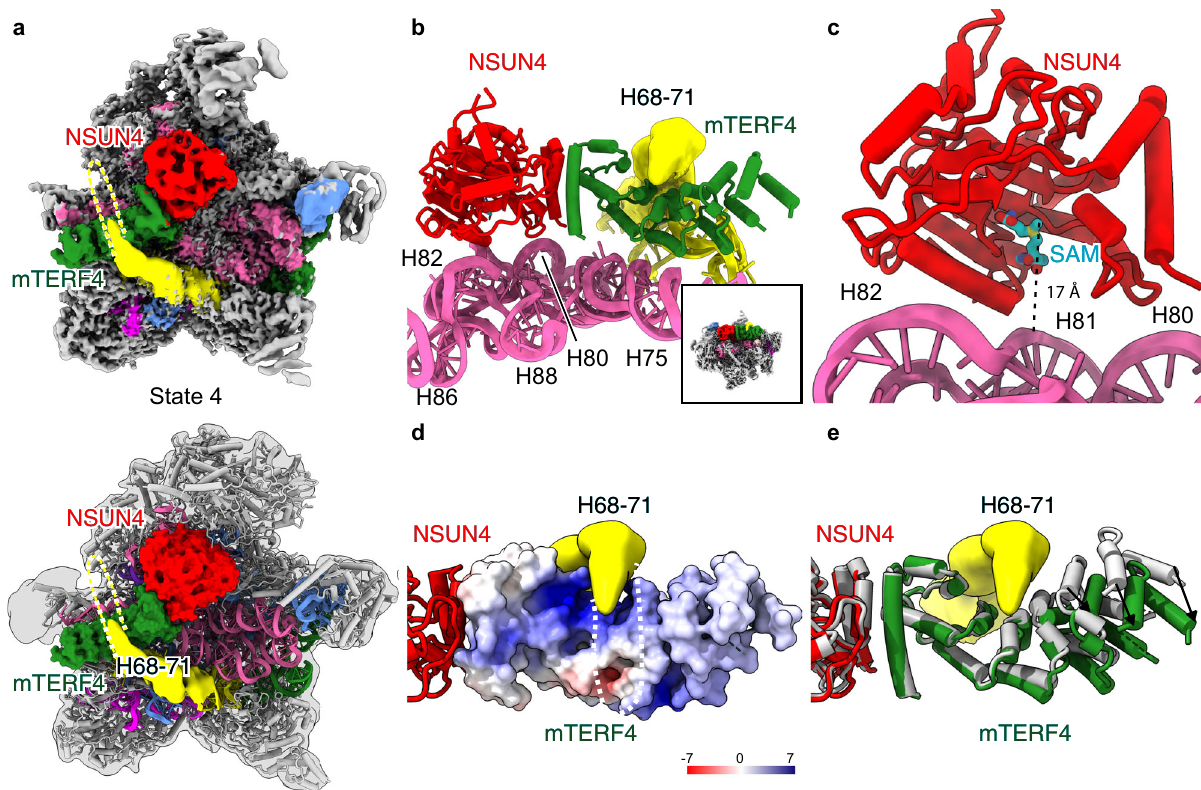
Fig. 5 Immature rRNA helices H68 – 71 and NSUN4 – mTERF4 complex in state 4. a View onto the intersubunit side of the map (top) and model (bottom) of state 4. The NSUN4 – mTERF4 complex is shown as a surface model. b , c close-up views of the interaction between the NSUN4 – mTERF4 complex and the 16S rRNA, illustrating the distance between the catalytic center of NSUN4 and the 16S rRNA. To locate the active center of NSUN4 S-adenosyl methionine (SAM) was docked from the crystal structure (pdb:4FZV). d rRNA helices H68 – 71 interact with mTERF4 which is shown as surface and colored according to its surface potential. e Comparison of unbound mTERF4 (PDB: 4FZV, gray) with mTERF4 bound to the mitoribosome indicating conformational changes. Helices H68 – 71 in ( a , d ) are shown as yellow density with dashed